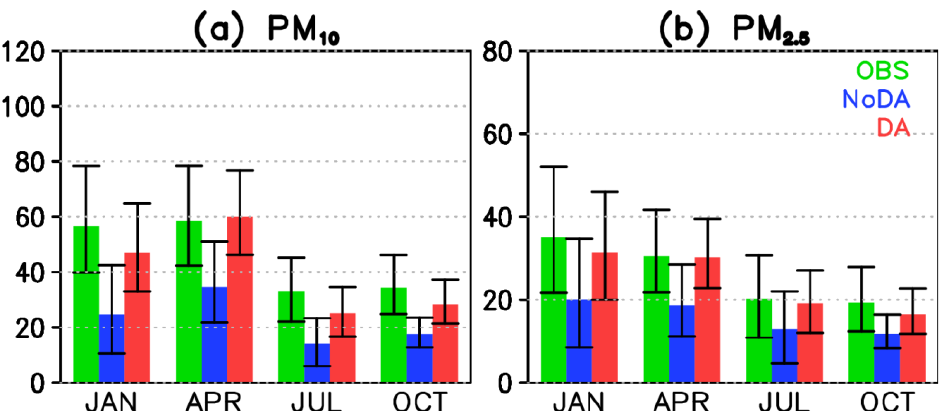
Figure 8. Time-averaged ( a ) PM 10 and ( b ) PM 2.5 concentrations in South Korea in each season for the observations (green), NoDA (blue), and DA (red). The one standard deviation of daily values is indicated by each bar.